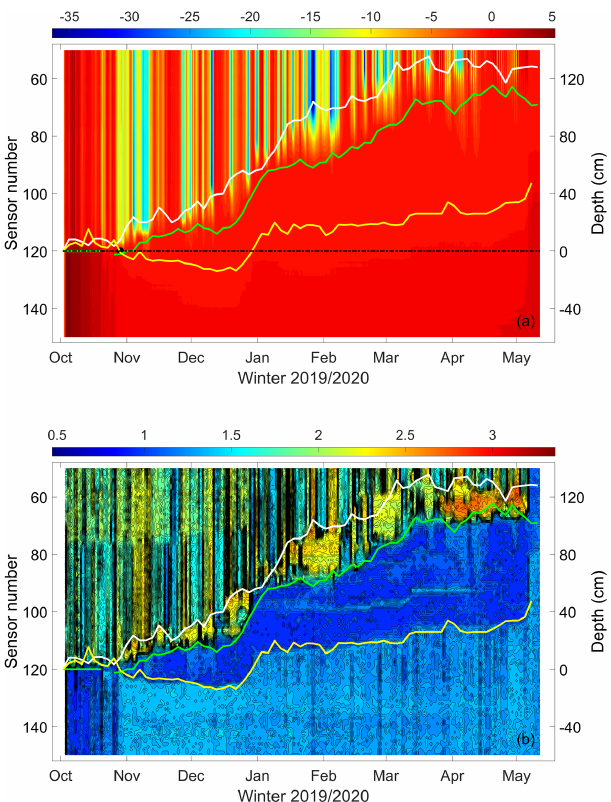
Figure 5. Time series of sensor position for the air–snow (white), snow–ice (green), and ice–water (yellow) interfaces, identified ap- plying the SIMBA algorithm. The SIMBA-ET observation is illus- trated as background in (a) and SIMBA-HT ratio (HT60 / HT90) in (b) . The black dashed line shows the sensor number (120) at the initial ice surface ( Z gi0 ). For clarity, we only illustrate sensors 50–